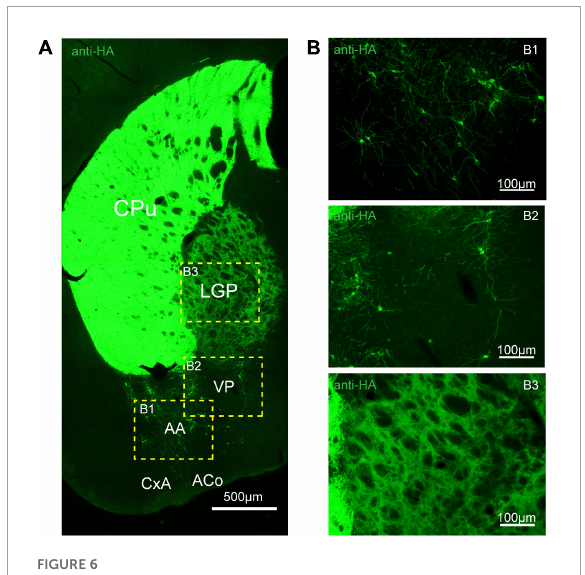
FIGURE6 Distribution of HA immunoreactivity in the amygdala and globus pallidus of adenosine A 2 A receptor (A 2A R)-tag mice. (A) Representative confocal image of HA expression in the amygdala and globus pallidus (0.22 mm behind bregma). Discrete and bright labeled cells could be seen in the amygdala, mainly in the basolateral part. Immunoreactivity in the globus pallidus was lighter than in the striatum. (B) High magnification of the areas (B1–B3) in yellow indicated in panel (A) . CPu, caudate putamen (striatum); LGP, lateral globus pallidus; AA, anterior amygdaloid area; PV, ventral pallidum; CxA, cortex-amygdala transition zone; ACo, anterior cortical amygdaloid nucleus. Scale bars as indicated in each picture.